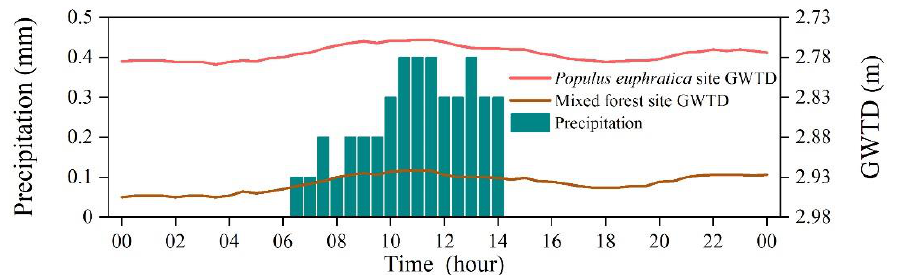
Figure 6. Time-series of precipitation and groundwater table depth (GWTD) on 3 September 2015 for the BJH case.